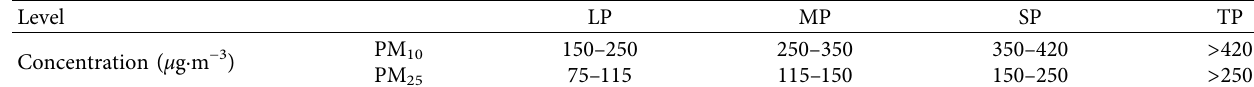
Figure 1: Distribution of 51 air quality monitoring stations in 13 cities of Hubei Province; note that the air quality monitoring sites are marked by black dots (unit: m). Table 1: Grade classification of pollution